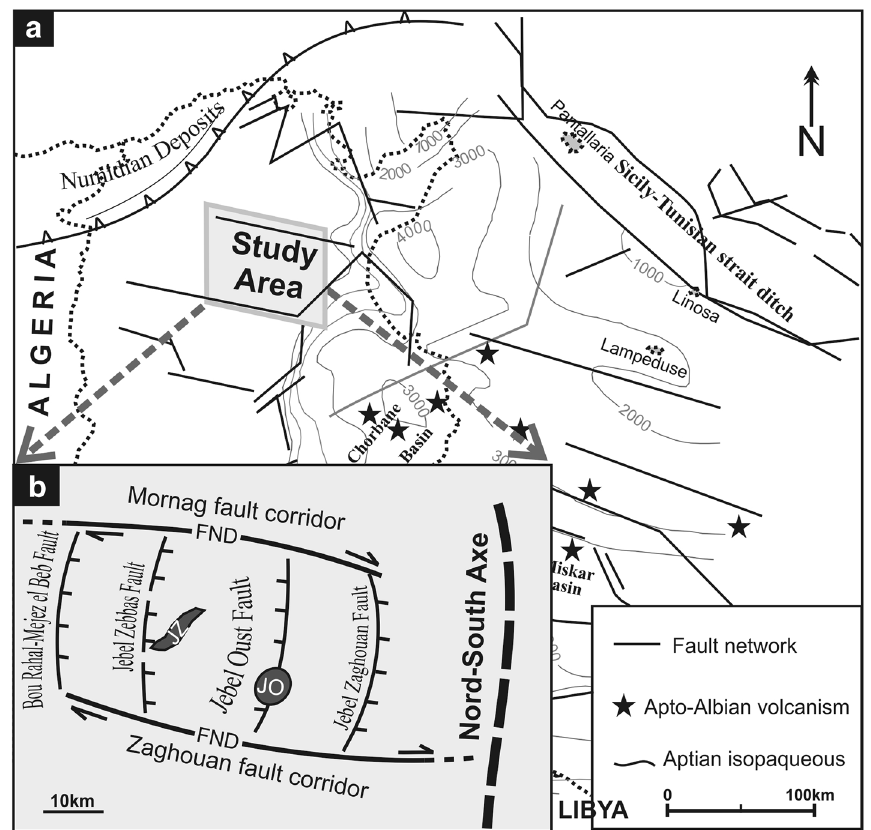
Fig. 2 a Aptian main structural elements of Tunisian showing study area (Boltenhagen 1981; redrawn); b schematic structural map of study area (Corel Draw figure exported into jpeg